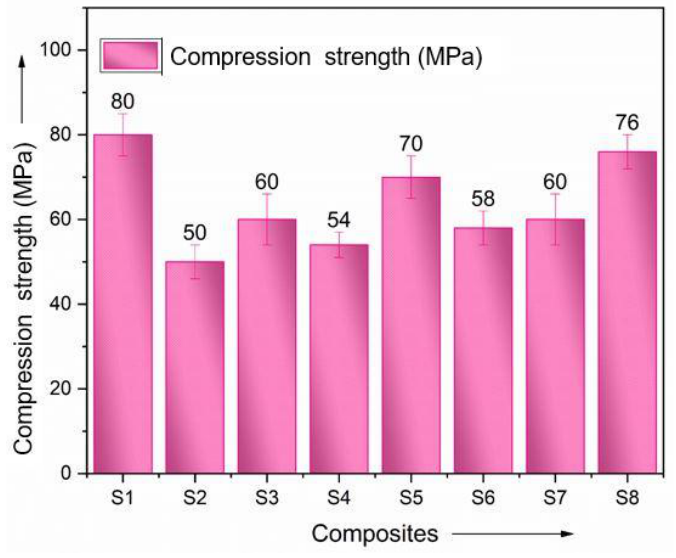
Figure 11. Comparison of compression strength.